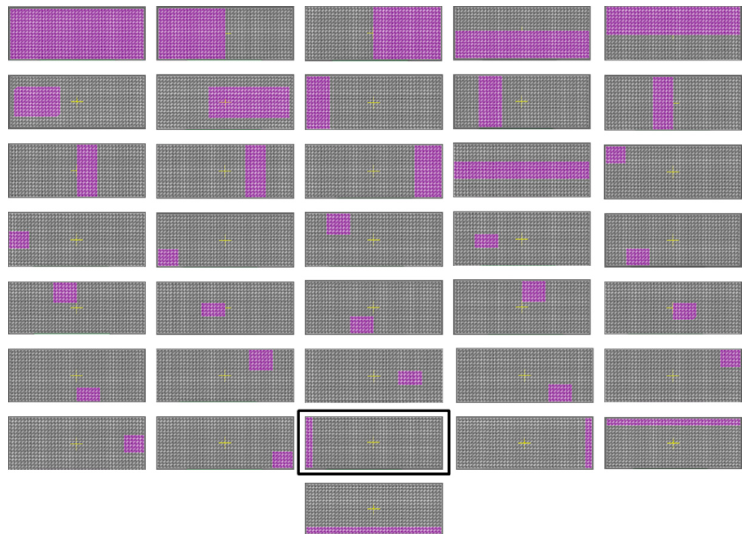
Figure 2. Geometries of preform samples used in feed forward NN (FF-NN) training. Preform resulting in the lowest maximum absolute deflection of the sample set is outlined.